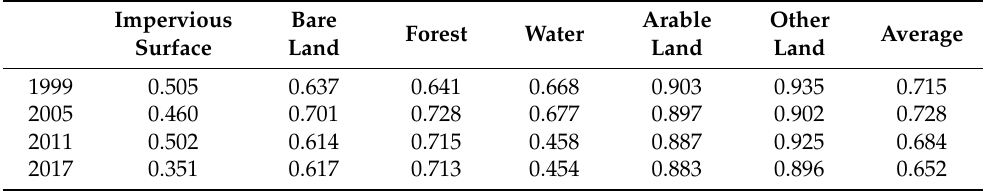
Table 3. Urban morphology resilience index of each landscape of